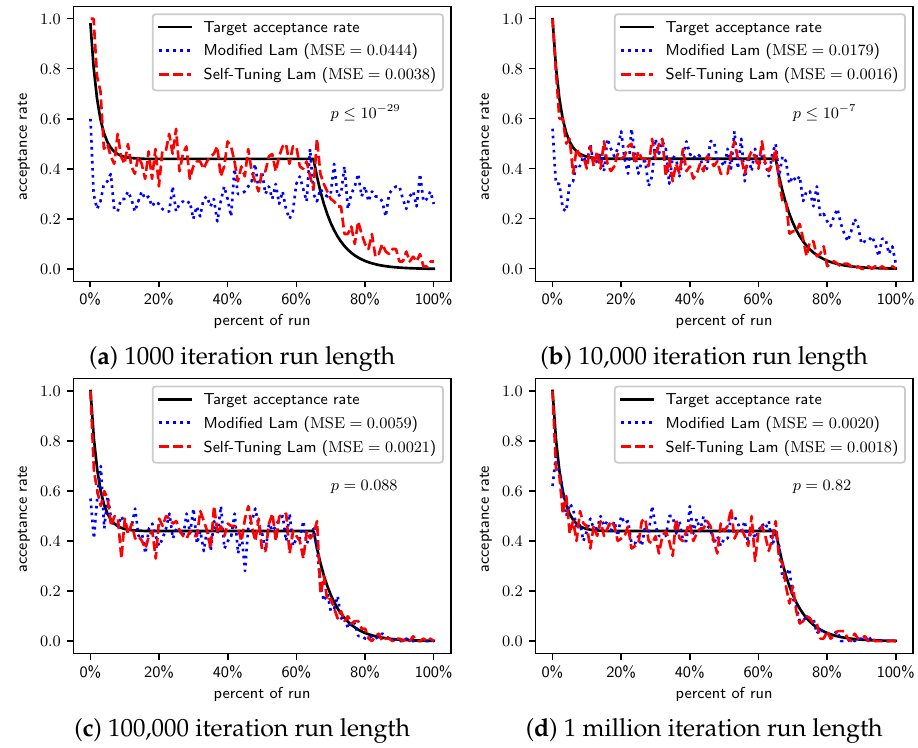
Figure 18. Minimize g 10 ( x ) : Self-Tuning Lam, Modified Lam, and target acceptance rates